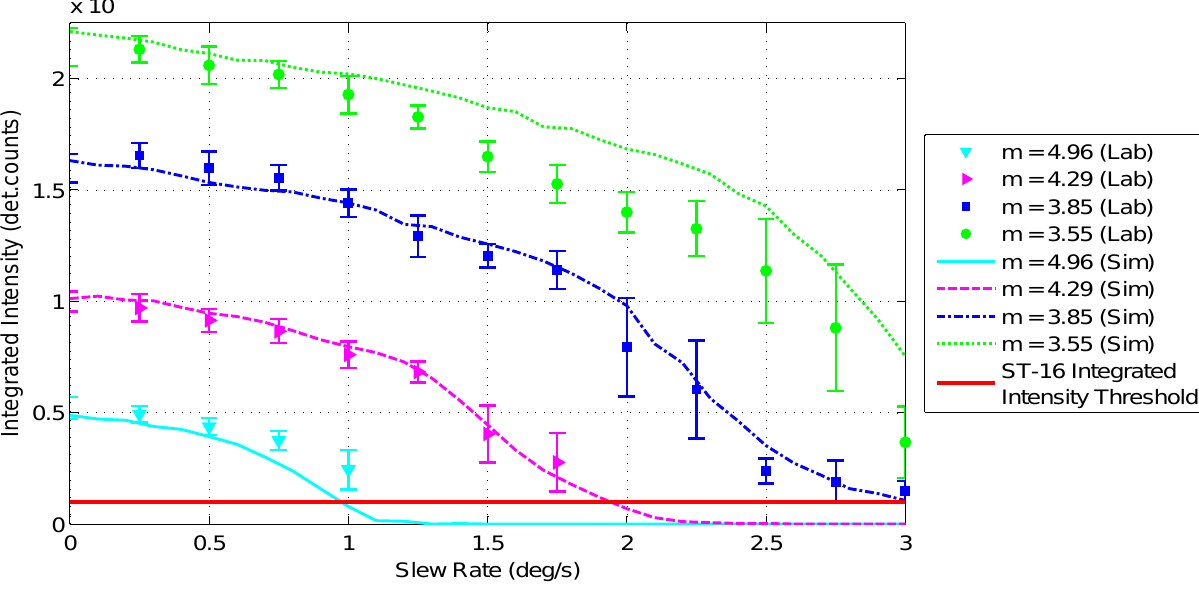
Figure 12. Lab measured star intensity at varying slew rates (Reed sensitivity model). Sim,